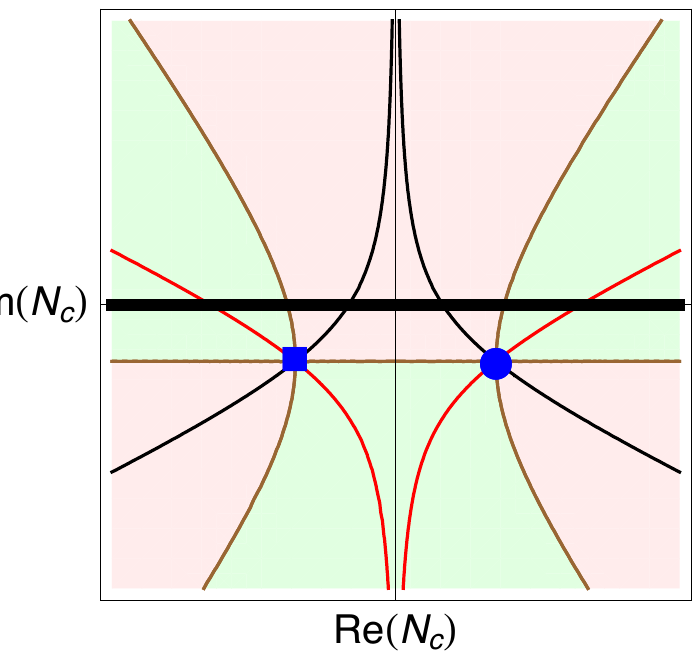
Figure 2 . We consider the case of no-boundary Universe where we impose the mixed boundary condition: with Euclidean momentum at t = 0 and fixed final size at t = 1 . The lapse action given in eq. (4.7) is complex. We take π 0 = − 3 i motivated by works of Hartle & Hawking [45, 74]. For the purpose of this numerical example we have set Λ = 3 , α = 2 and q 1 = 3 . We plot on x -axis real-part of N c while the y -axis is imaginary part of N c . The red lines correspond to steepest descent lines (thimbles J σ ), while the thin black lines are steepest ascent lines and denoted by K σ . Both the saddle points are depicted in blue: N − (blue-square) and N + (blue-circle). Both saddle points are relevant . The steepest ascent lines emanating from both of them intersects the original integration contour ( −∞ , + ∞ ) which is shown by thick-black line. The Morse-function h is same for both saddle points: h ( N ± ) > 0 . The light-green region is allowed region with h < h ( N σ ) for all values of σ . The light-pink region (forbidden region) has h > h ( N σ ) for all σ . The boundary of these region is depicted in brown lines. Along these line we have h = h ( N σ )